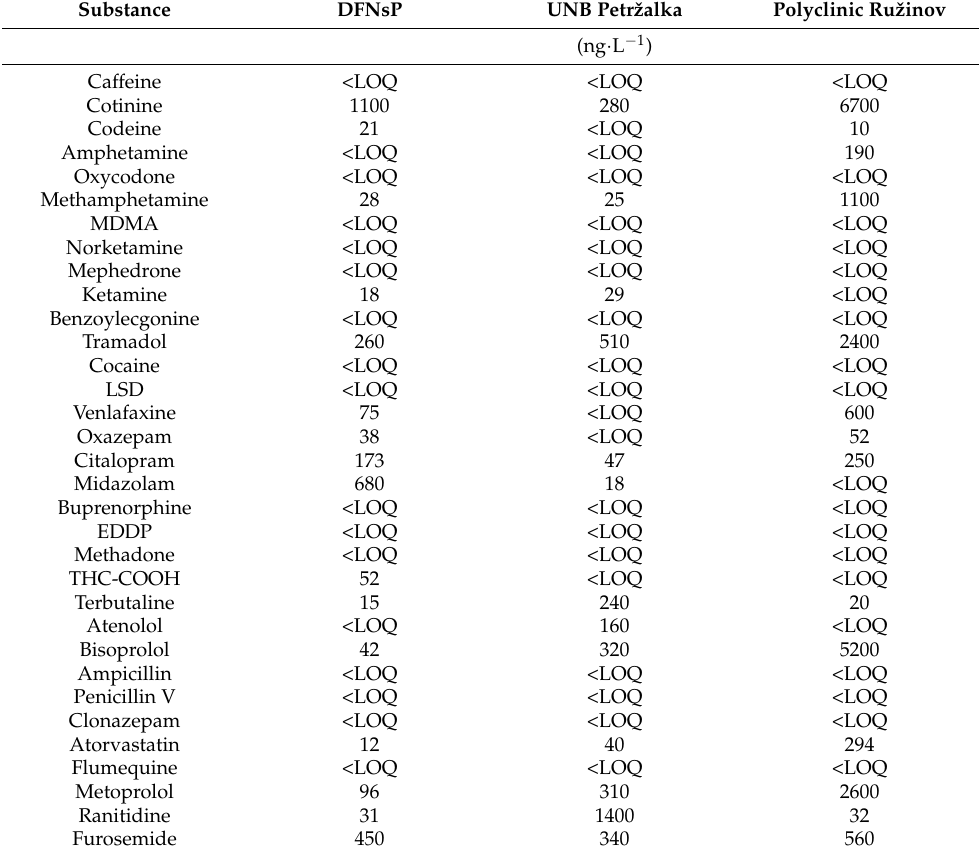
Table 2. Composition of wastewater in selected Bratislava healthcare facilities with emphasis on the presence of specific micropollutants (pharmaceuticals and drugs) [9].